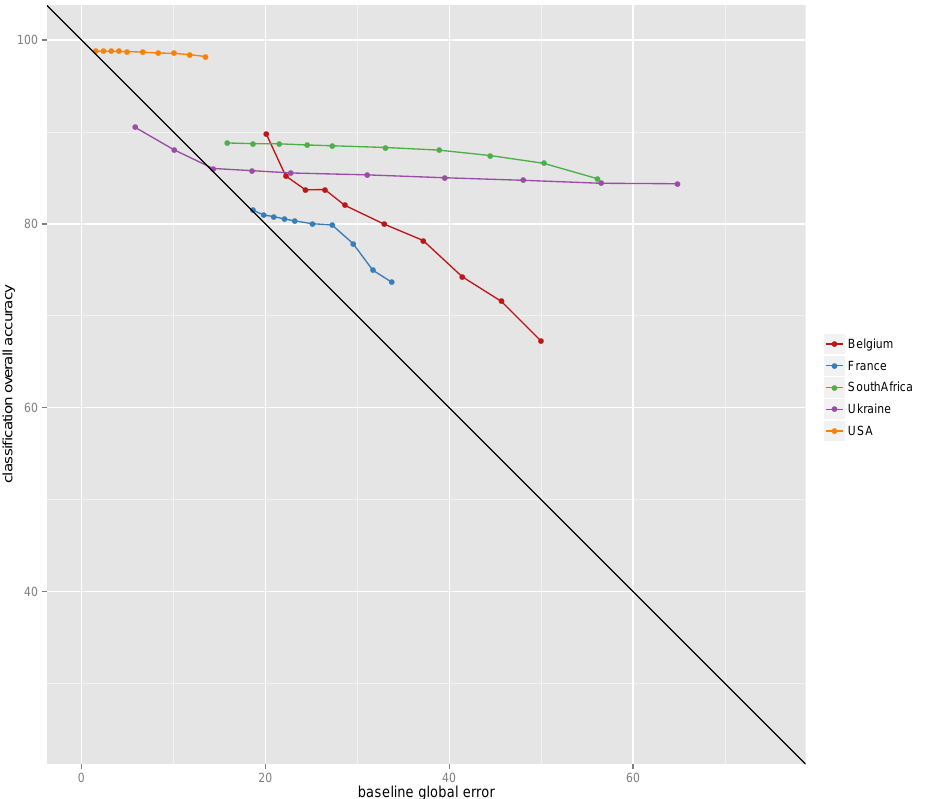
Figure 8. Effect of baseline global error (GE) ( GE = 1 − OA ) on classification overall accuracy (OA). Increasing baseline GE was linked to the artificially-added noise (the lower the noise, the lower the GE) and induced a classification OA decrease. The 1:1 line represents the same accuracy for both the baseline and the